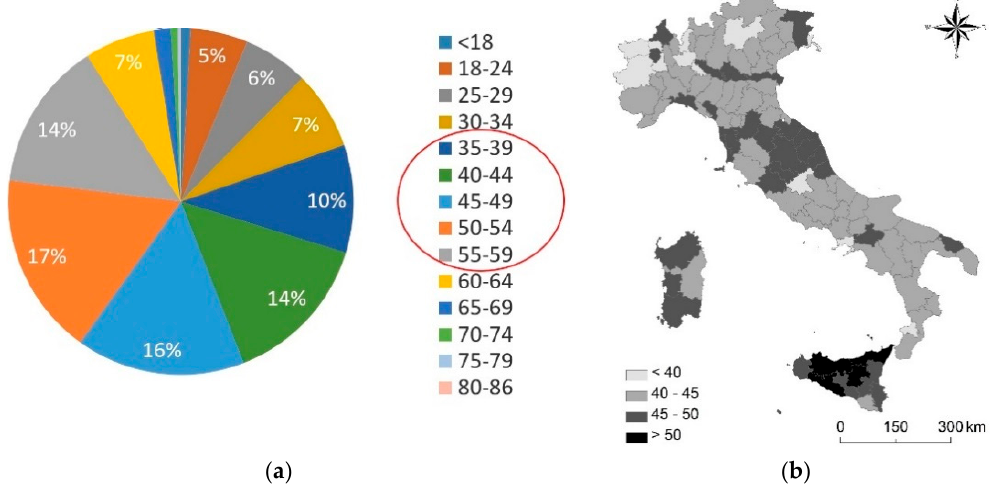
Figure 3. Age groups of people involved in accidents ( a ) and average age of the injured people at provincial level ( b ). Table 1. Number of foreign population involved in work-related accidents by geographical subdivision.